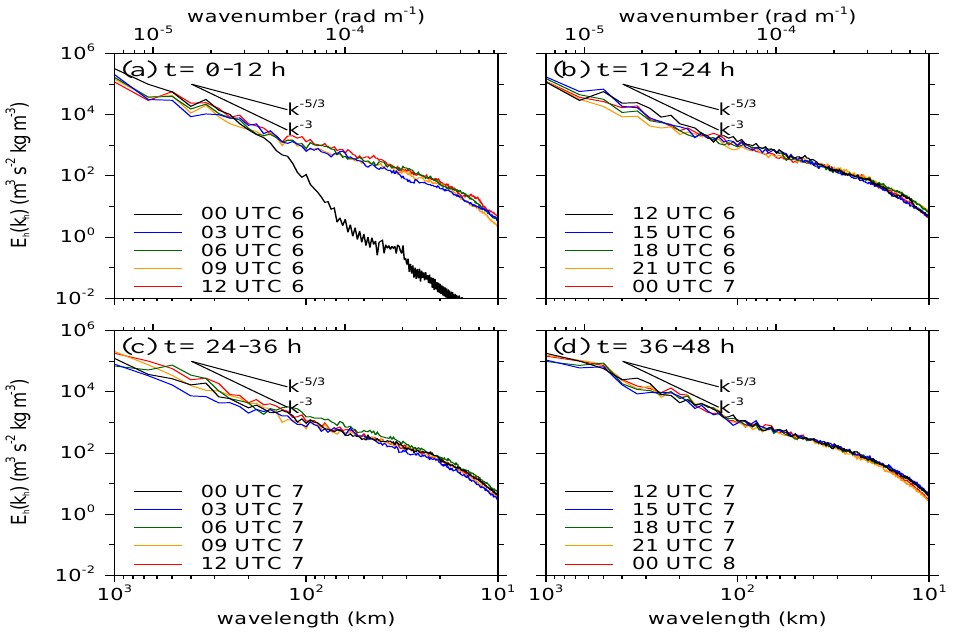
Figure 5. Time evolution of the HKE spectrum [ E h ( k h )] averaged vertically over the lower stratosphere for ( a ) 0–12 h, ( b ) 12–24 h, ( c ) 24–36 h, and ( d ) 36–48 h. Spectra are plotted every 3 h. The reference lines correspond to the − 3 and − 5 / 3